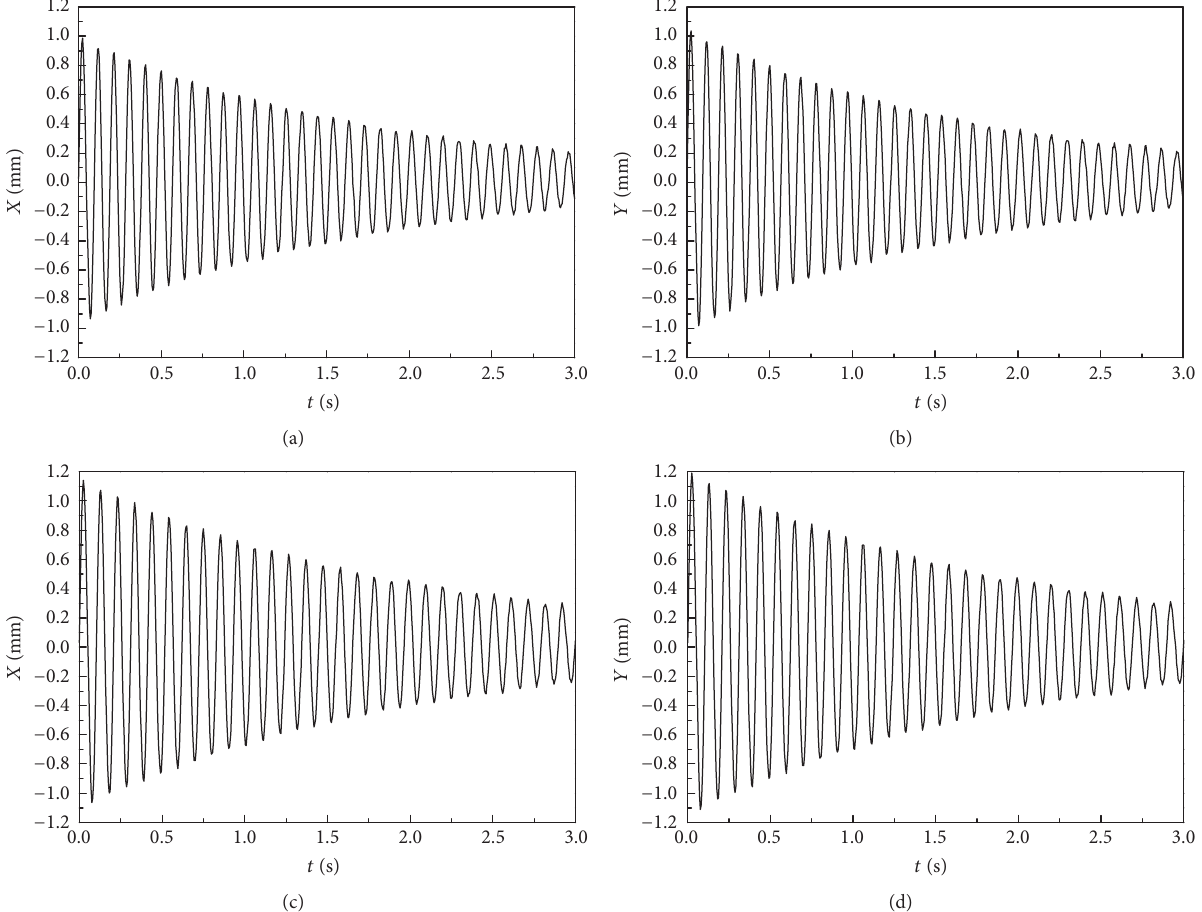
Figure 5: Time histories of the free vibrations of the monitored tubes in air. (a) Aluminum tube in the in-line direction, (b) aluminum tube in the transverse direction, (c) stainless steel tube in the in-line direction, and (d) stainless steel tube in the transverse